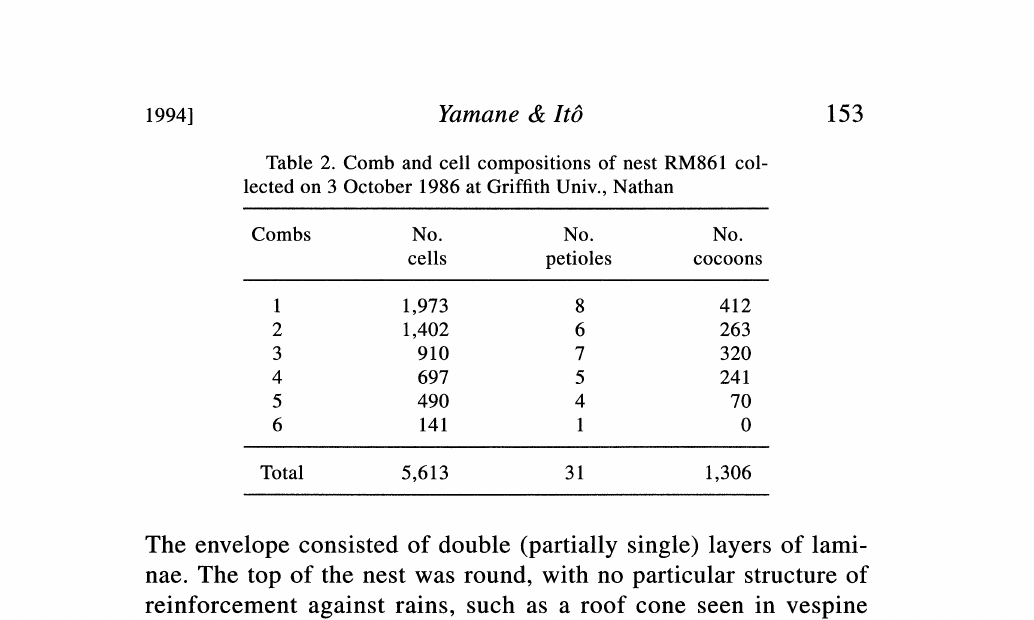
Table 2. Comb and cell compositions of nest RM861 col- lected on 3 October 1986 at Griffith Univ., Nathan Combs No. No. No.